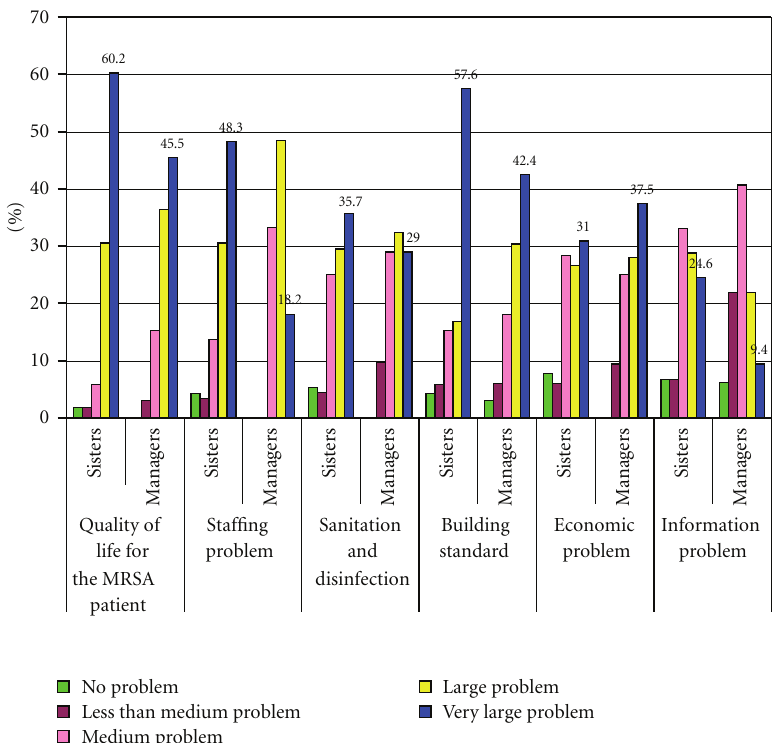
Figure 3: Nursing home problems associated with MRSA: quality of life, sta ffi ng, building standard, economy, information, sanitation, and